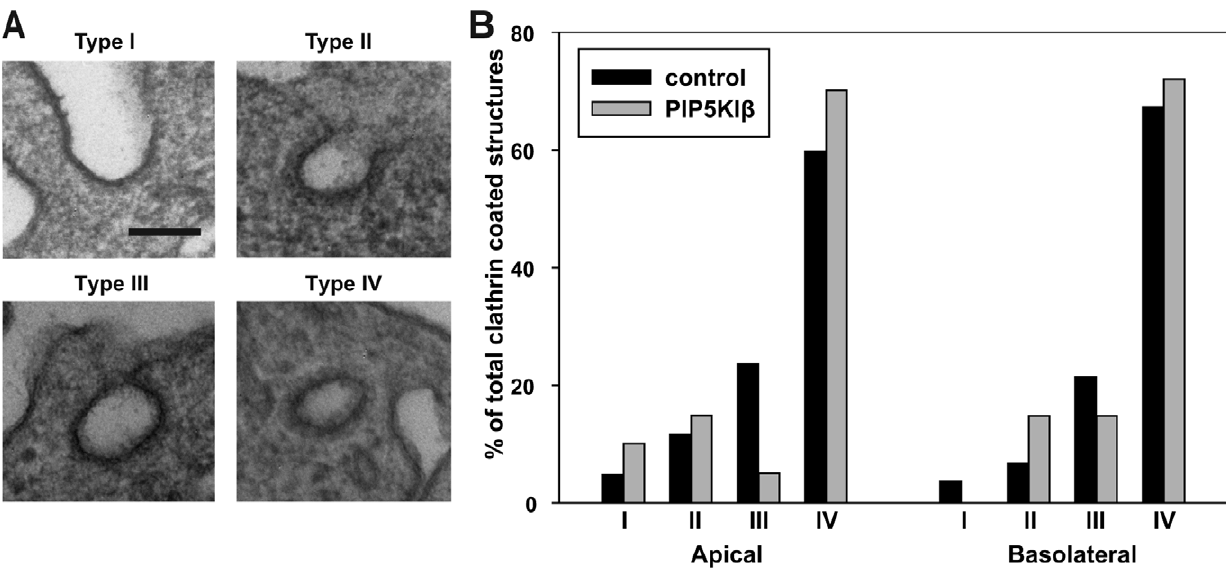
Figure 9. Apical CCP maturation is enhanced in PIP5KI b -overexpressing cells. MDCK cells cultured on permeable supports and infected with control adenovirus or adenovirus encoding PIP5KI b were processed for electron microscopy. (A) Representative EM images show each of the stages of CCP maturation that were quantitated for analysis. Scale bar: 100 nm. (B) Analysis of data from 33 control cells and 35 PIP5KI b - overexpressing cells shows a decrease in the frequency of type III CCPs upon overexpression of PIP5KI b .